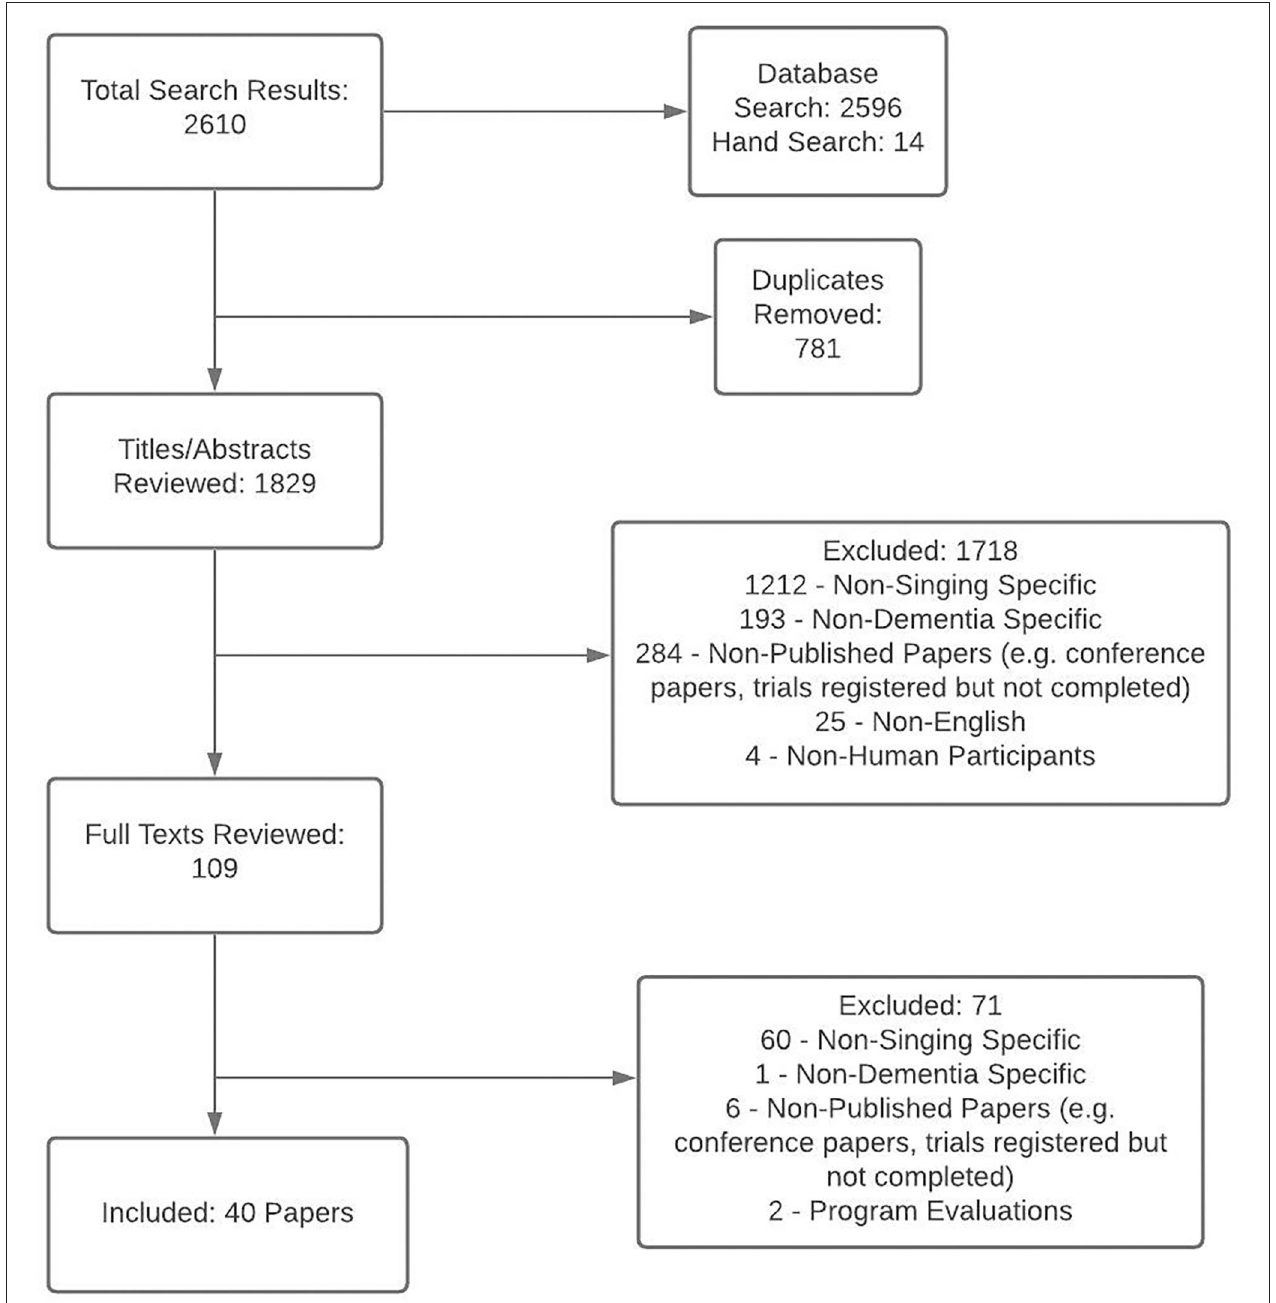
FIGURE 4 | PRISMA Flowchart depicting study selection